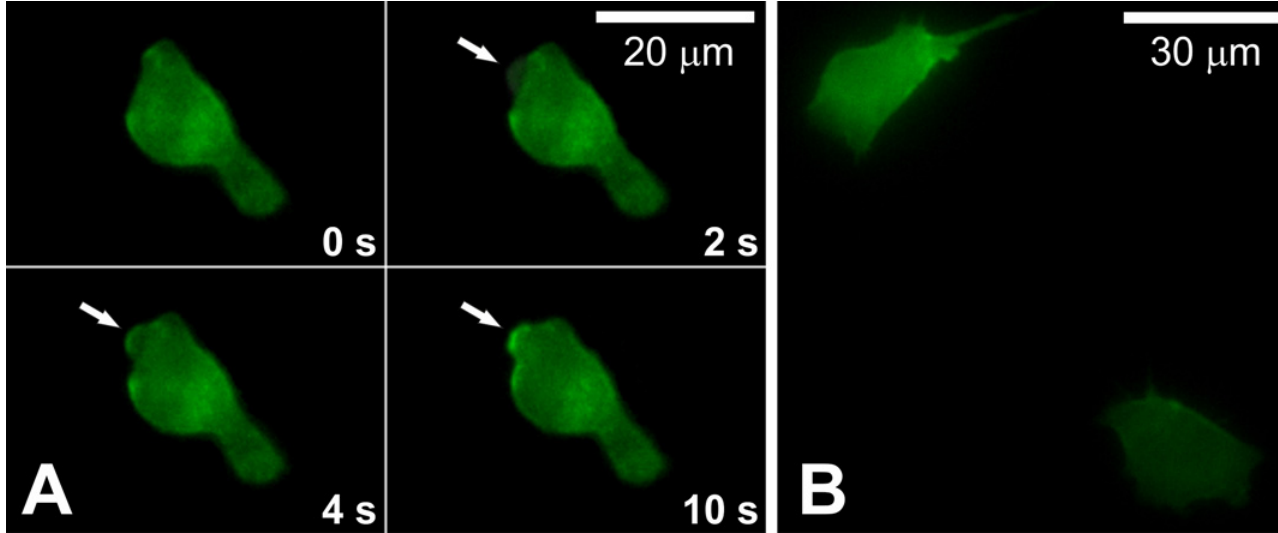
Fig 2. Distribution of F-actin in migrating BC and LC cells. Cells were transfected with LifeAct, a 17-amino-acid peptide, which stains F-actin in eukaryotic cells. ( A ) Sequence of frames showing bleb formation (indicated by arrow) in weakly adherent BC cells. (B) Strongly adherent lamellipodia forming LC cell.